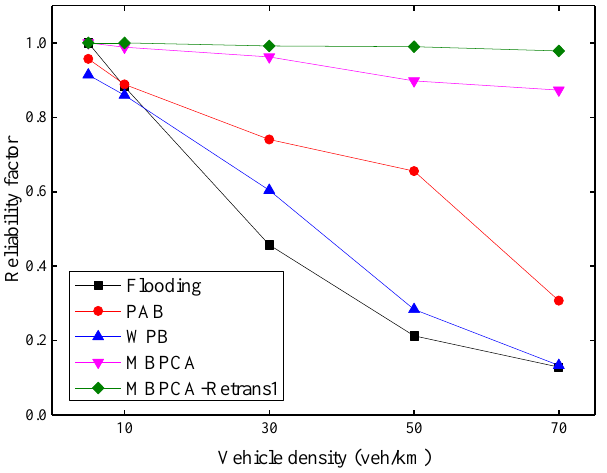
Figure 14. Reliability factor under different vehicle densities. Figure 15 shows the redundancy factors of several protocols to evaluate the control effect of broadcast storms. The redundancy factor indicates the degree of message forward- ing redundancy in multi-hop broadcasting, and a large redundancy factor may lead to a higher transmission collision probability. In general, the redundancy factor increases with increasing vehicle density. This is because more vehicles mean more forwarding nodes, which will increase the redundancy factor. Both MBPCA and PAB can maintain a low re- dundancy factor because a candidate forwarder will cancel its redundant forwarding after receiving the forwarding from the other neighbor nodes. MBPCA with one retransmission has a higher redundancy factor, but it can achieve nearly 100% packet delivery ratio and reliability factor. Therefore, we should only use retransmission for a few message types that require an extremely high delivery ratio and reliability in practical applications. In fact, the flooding broadcast will have a much higher redundancy factor than the simulation result if the forwarding collision of Emergency messages is not considered. Because forwarding collision not only reduces the reliability factor, but also reduces the number of redundant packets received by the node. Compared with flooding, WPB can reduce the redundancy factor, but the calculation of the node forwarding probability does not consider the vehicle density, so its improvement is limited. It should be noted that unlike the retransmission mechanism of our proposed MBPCA protocol, the retransmission mechanism of the WPB protocol only sets the forwarding probability to 1 when the forwarding of the neighbor node is not received; it does not forward the same message